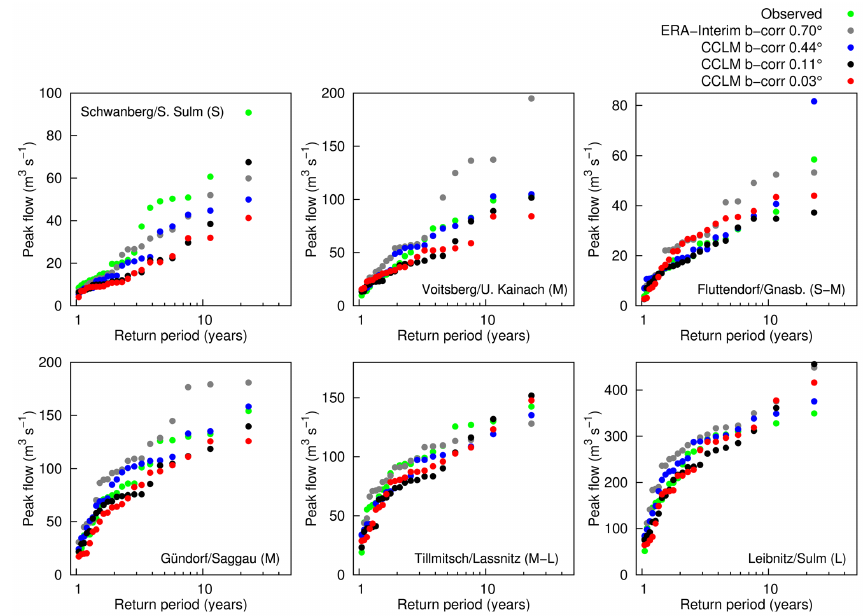
Figure 13. Simulated maximum annual flood peaks using bias-corrected CCLM data as input and observed maximum annual flood peaks vs. empirical return periods (Eq. 1, flood frequency plots) of the selected gauges in the period 1989–2010.